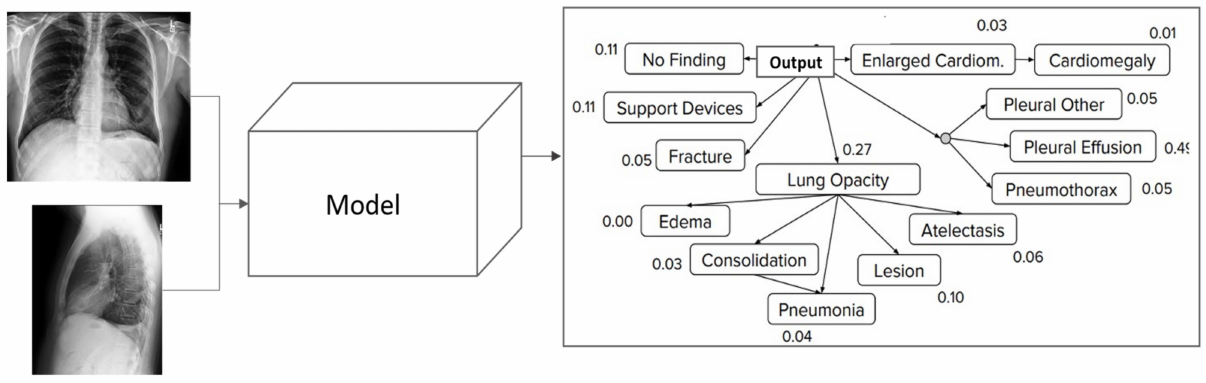
Figure 7. Predicting abnormality (pneumonia) from